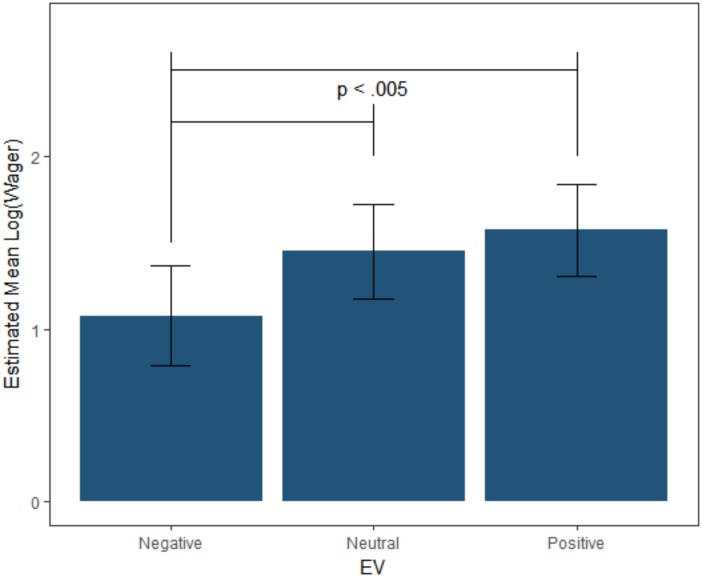
Fixed effect estimates and confidence intervals for the log transformed bankroll wagered in each CASE game. Individuals tended to wager more in the neutral and positive games than the negative game.